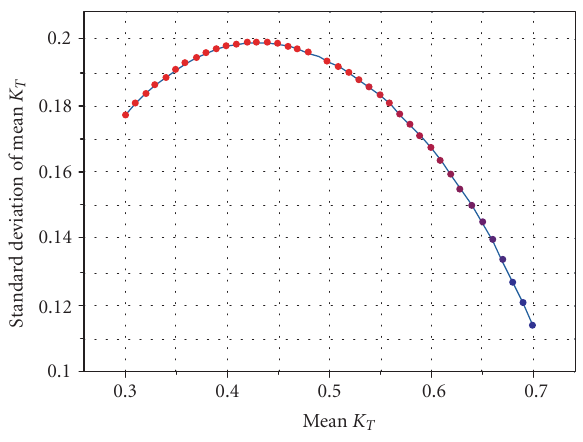
Figure 3: Estimated standard deviations, σ d , for di ff erent mean clearness indexes.